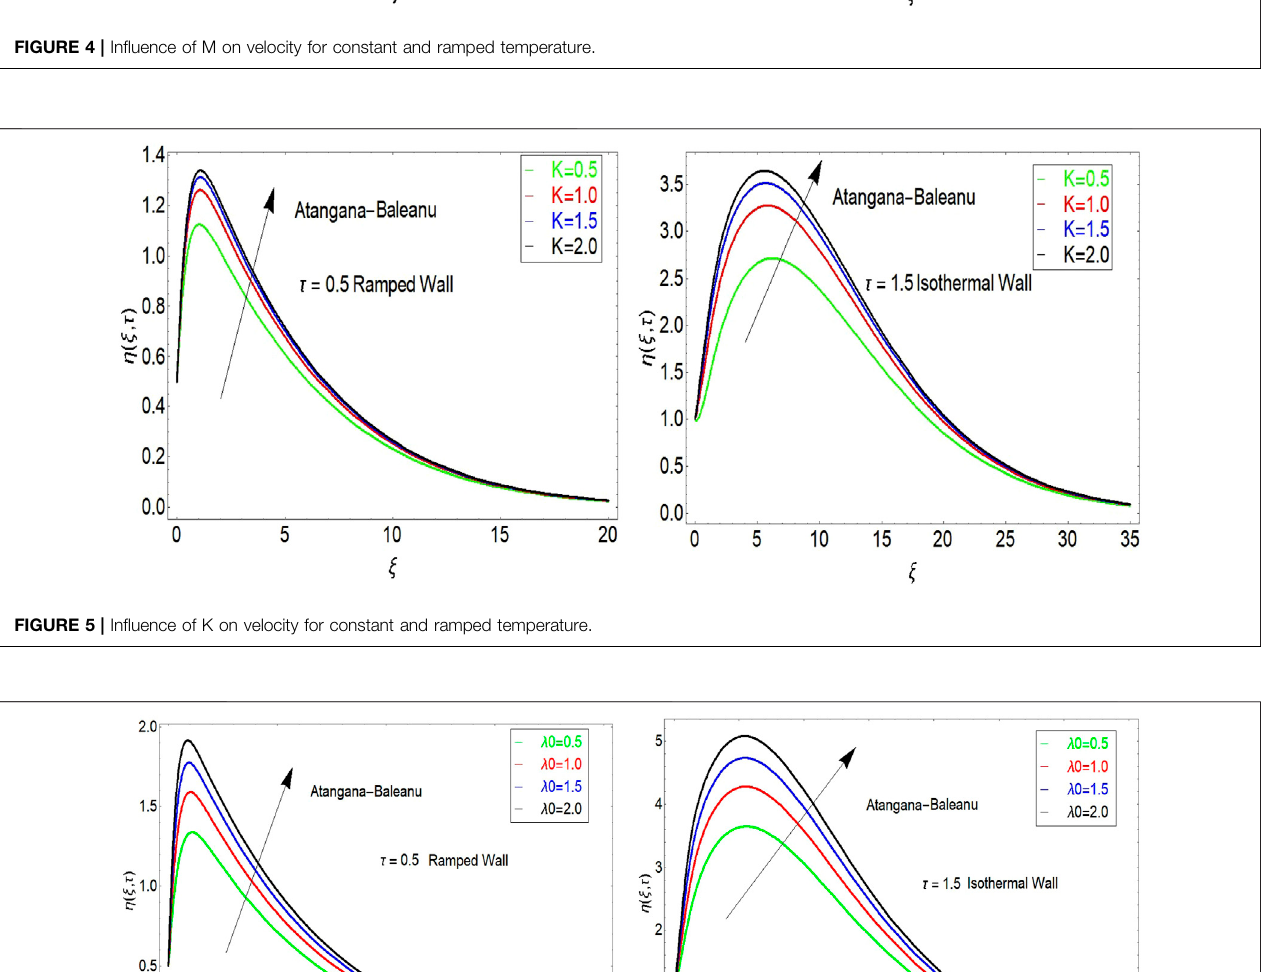
Frontiers in Physics |